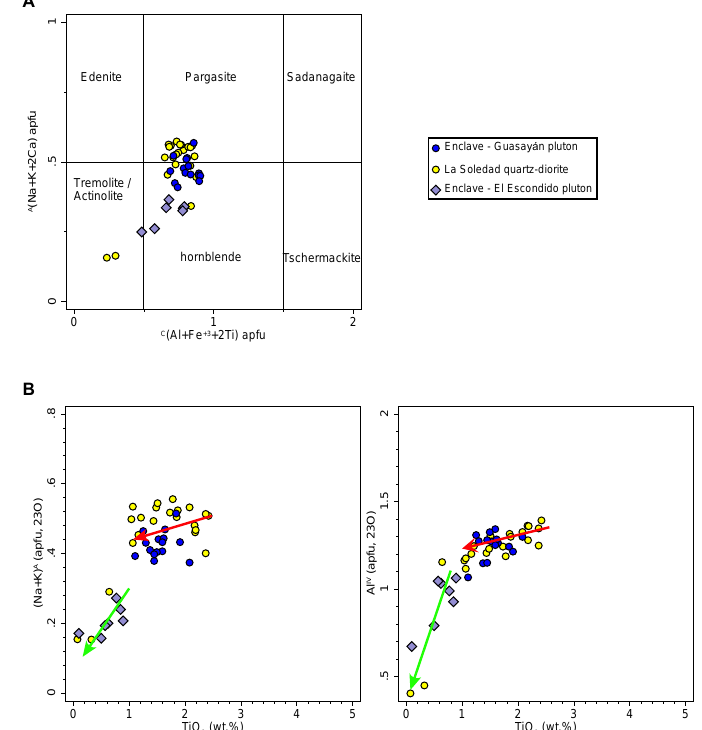
Figure 5. Composition of amphiboles from the granitoids of the Sierra de Guasayán. ( A ) Amphibole classification diagram of [65]. ( B ) (Na + K) A vs. TiO 2 and Al IV vs. TiO 2 diagrams. Red arrows show primary trends and green arrows secondary trends from [14]. apfu: atoms per formula units. In the mafic enclave from the El Escondido pluton (GUA 23026), amphibole was mag- nesio-ferri-hornblende with roughly homogeneous Mg/(Mg + Fe 2+ ) values of 0.60–0.65 that